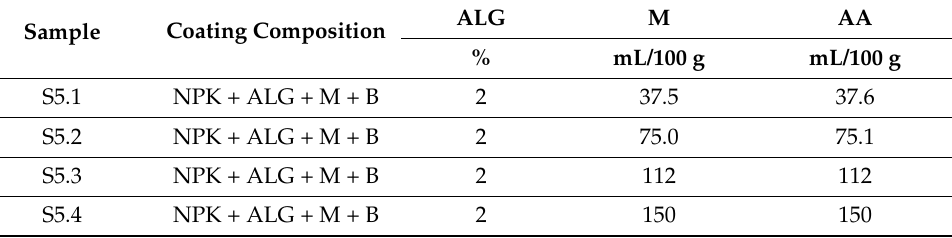
Table 2. Compositions of seeds coating solutions (ALG—sodium alginate,